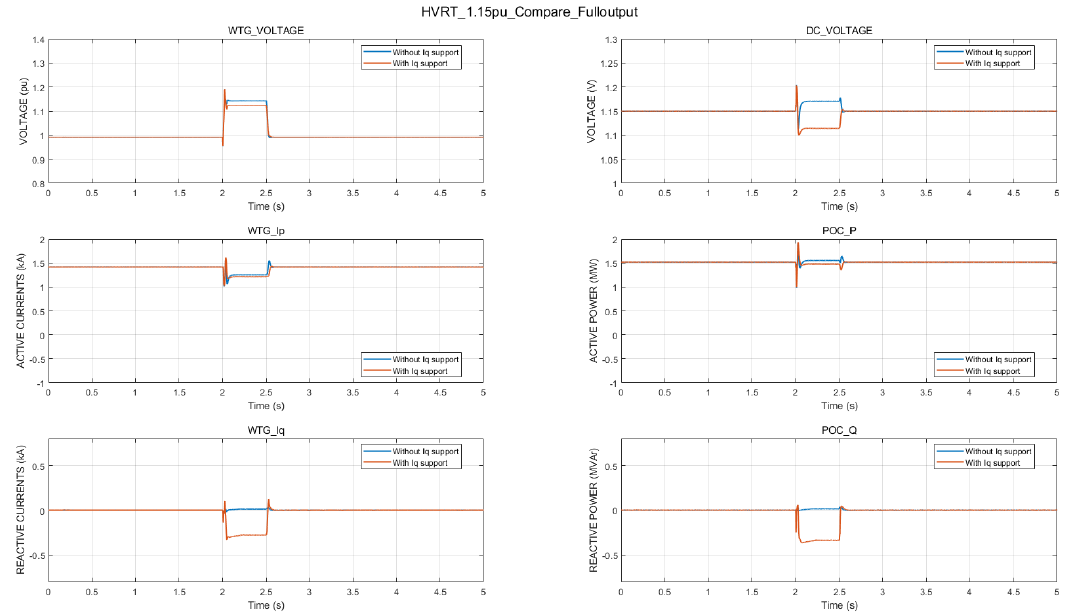
Figure 13. Comparison study of a 1.15 pu HVRT incident with half active power output.